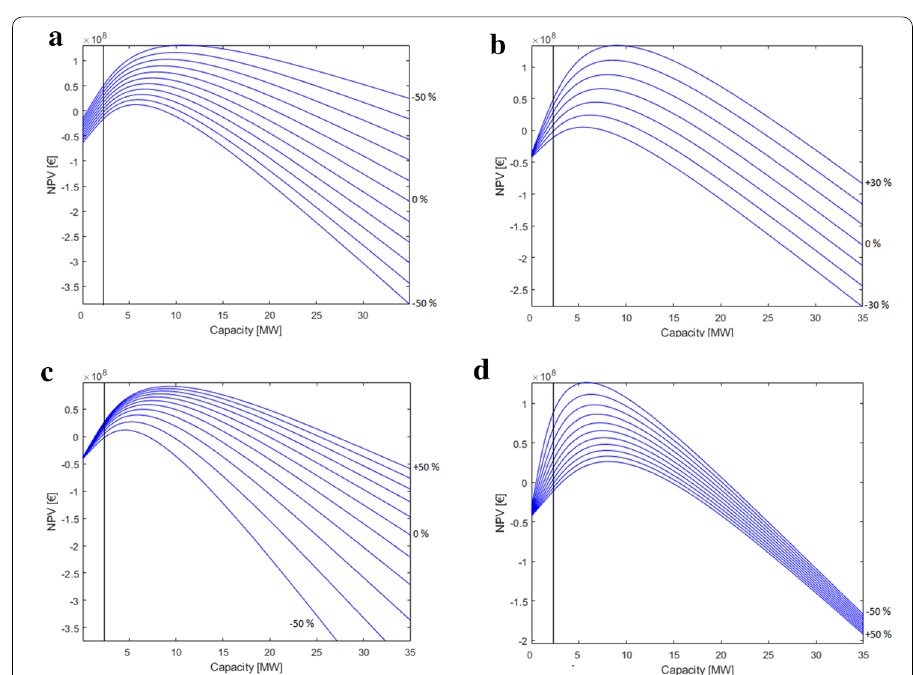
Fig. 6 Sensitivity analysis for key parameters on the optimization results—Case 2. The vertical line represents the production within “sustainable manner boundaries” in the sense of 100 years of reservoir lifetime. a Variation of subsurface cost; b variation of feed-in tariff; c variation of average well productivity; d variation